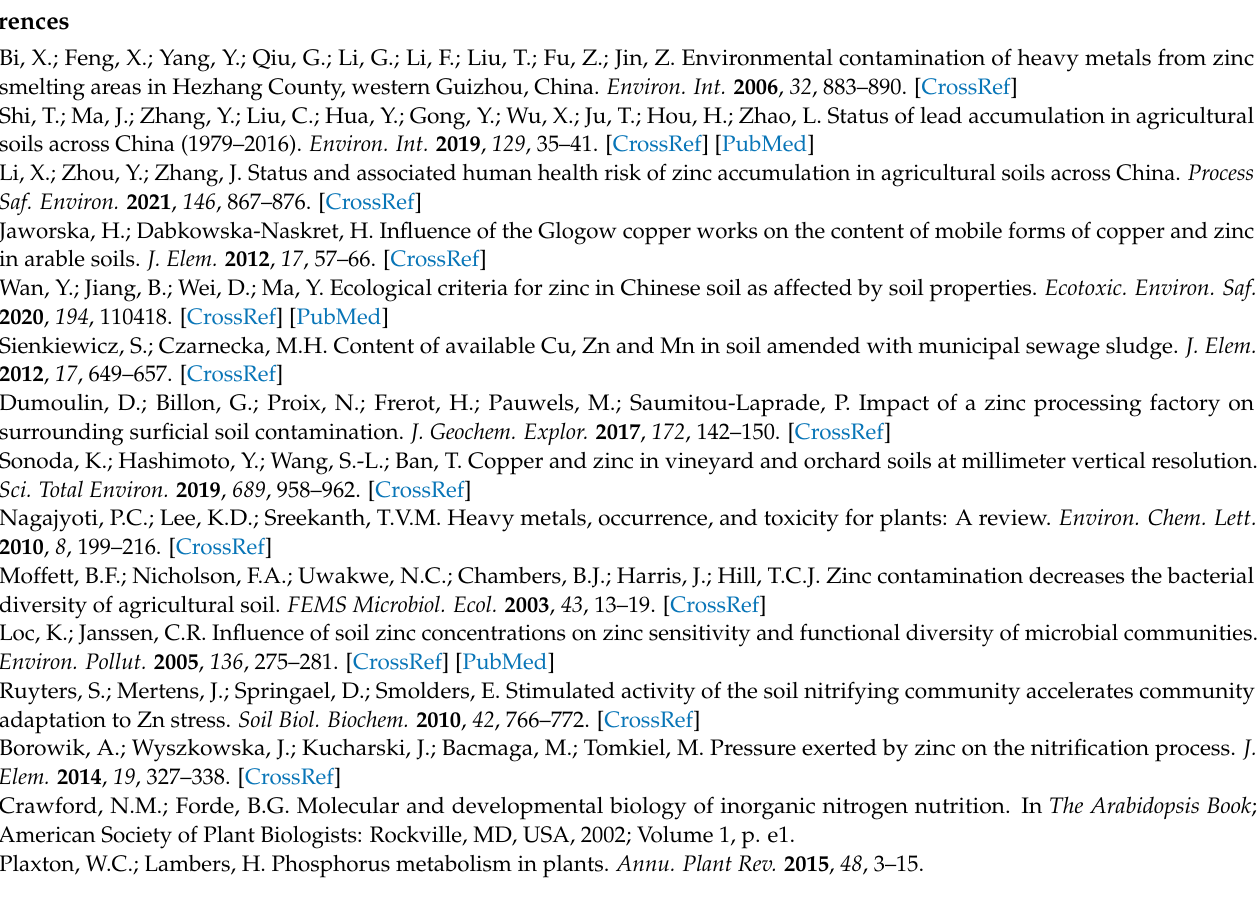
Figure S5: Simpson index, Venn diagram, and principal coordinate analysis of bacterial communities in rice rhizosphere soil with different levels of